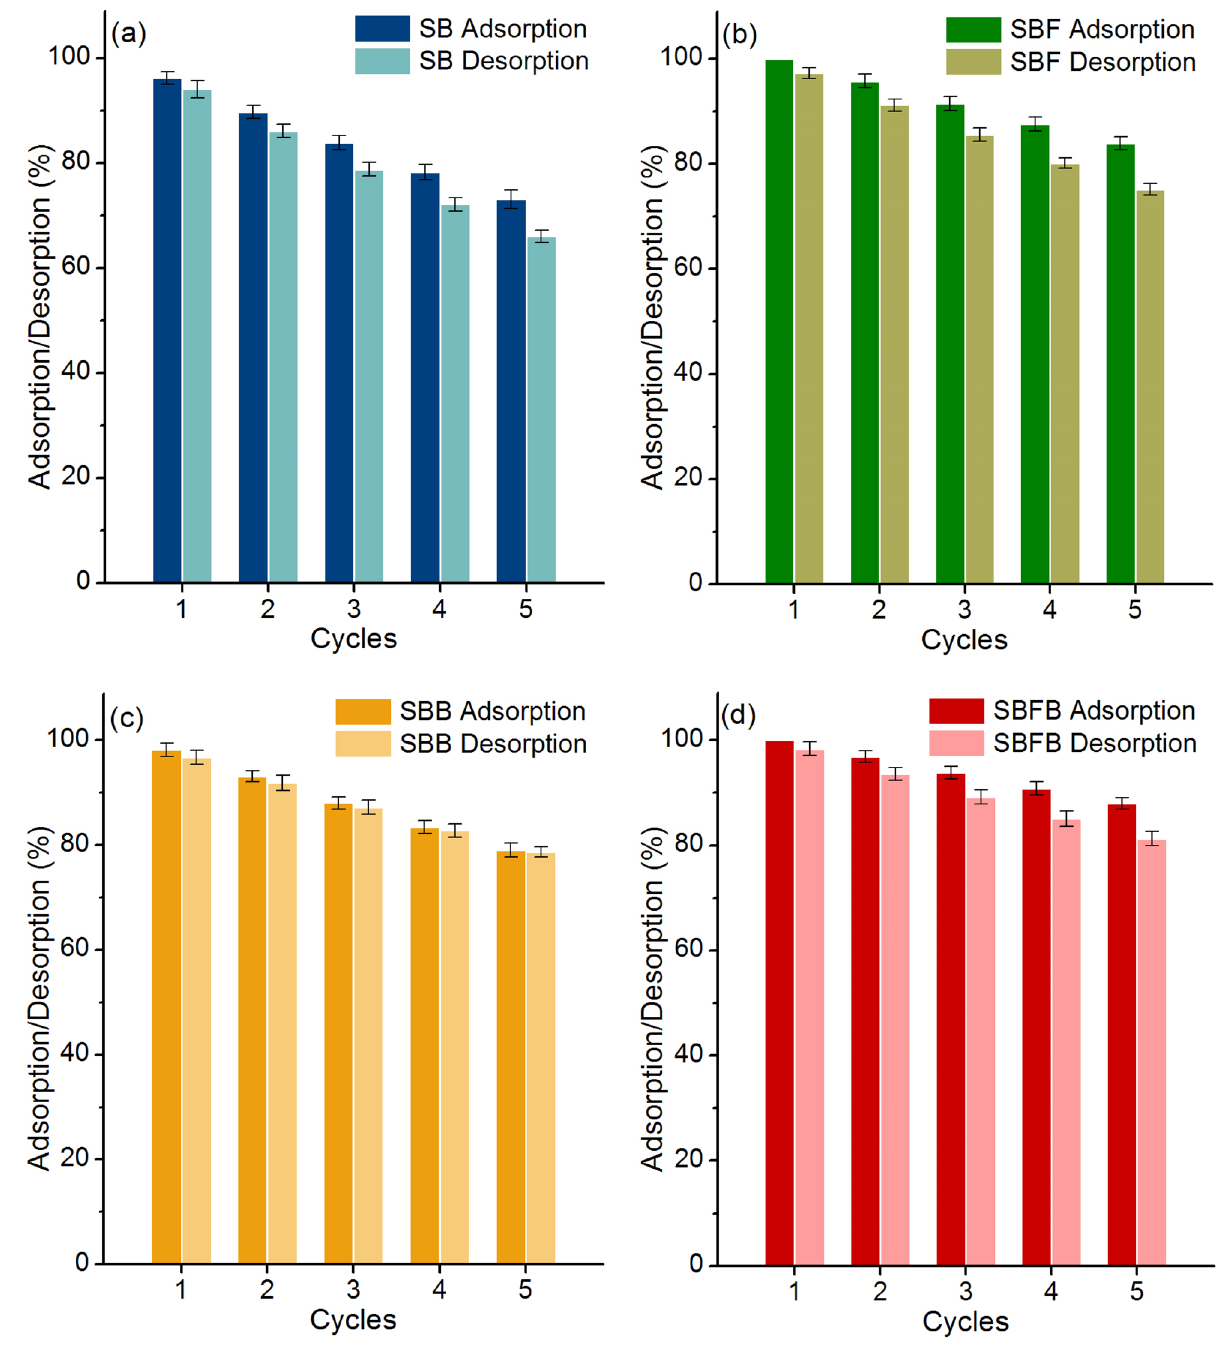
Figure 9. The desorption experiments of ( a ) sugarcane bagasse powder (SB), ( b ) sugarcane bagasse powder doped iron(III) oxide-hydroxide (SBF), ( c ) sugarcane bagasse powder beads (SBB), and ( d ) sugarcane bagasse powder doped iron(III) oxide-hydroxide beads (SBFB) for lead